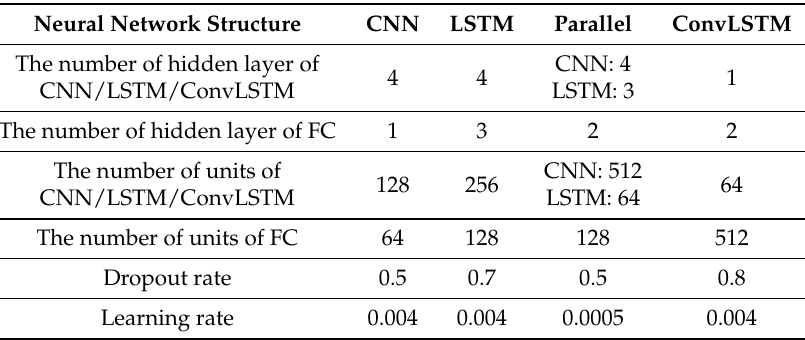
Figure 9. Parallel model—diagram. Table 2. Result of the grid